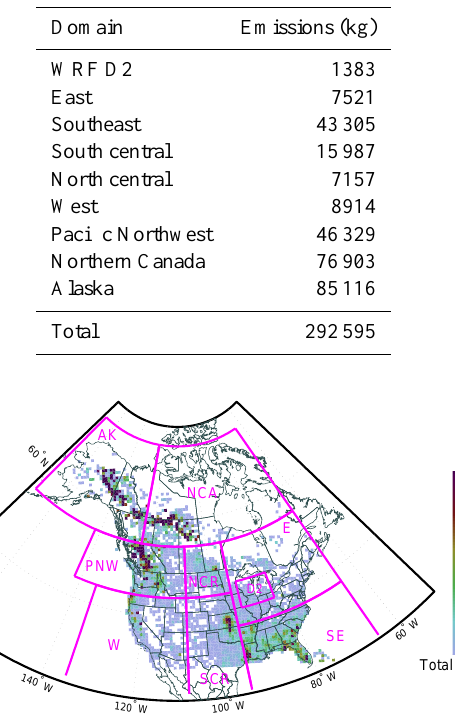
Fig. 3. Forest fires emissions from 28 June 2004 to 11 May 2005, showing the different domains used: Alaska (AK), Northern Canada (NCA), pacific northwest (PNW), west (W), north central (NCR), south central (SCR), east (E), southeast (SE). Note that the east domain does not include WRF domain 2 (D2) which is calculated separately. The maximum emissions in a cell is 7224kg, in Alaska. See Table 2 for total emissions by domain. Areas with zero emissions shown in